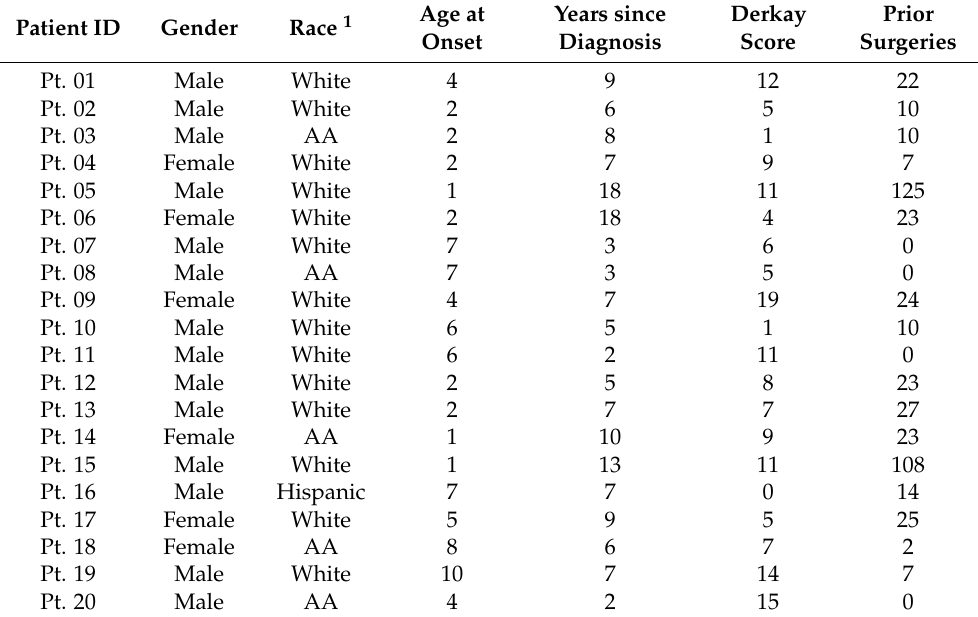
Table 2. Characteristics of the prospective cohort at the time of